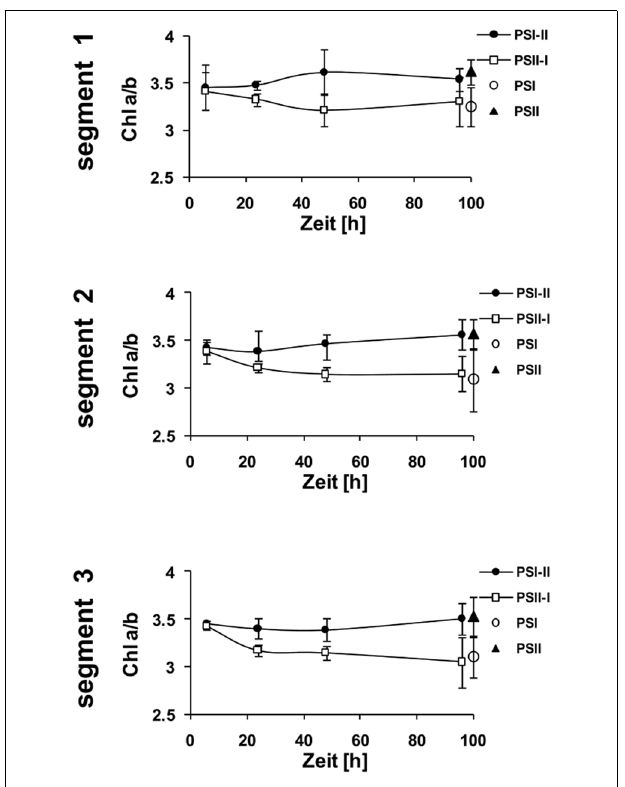
FIGUREA1 | Kinetic changes of Chi a/b ratio in defined segments of maize seedlings acclimated to different light qualities. Growth light conditions are given in the right margins. Plants under PSI-light were shifted to PSII-light and vice versa and harvested at indicated time points after the shift and compared to non-shifted controls. Data represent at least three independent biological replicates, standard deviation is